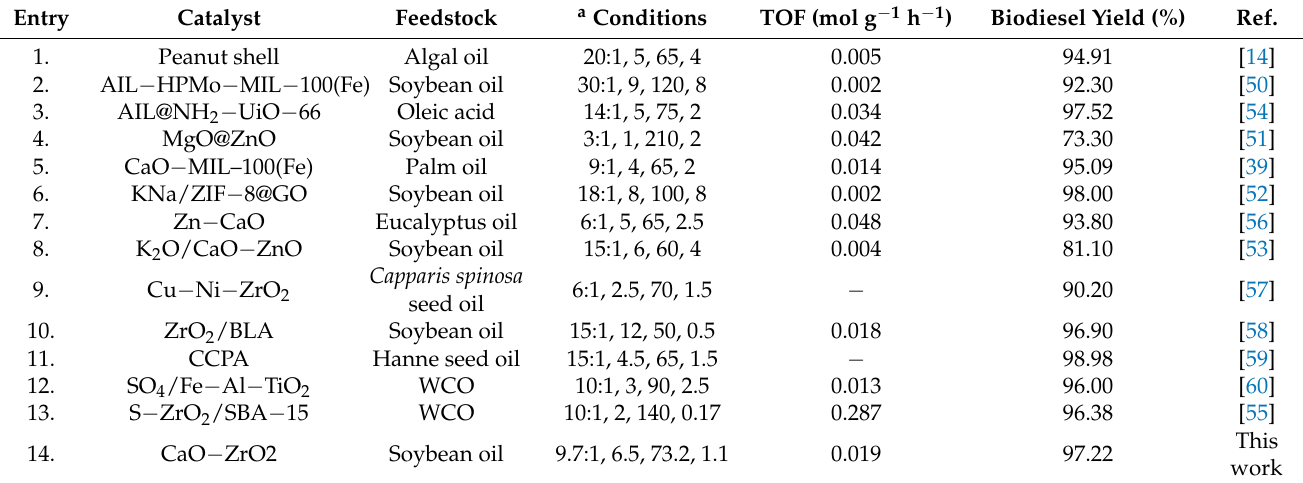
Table 5. Comparison of different heterogeneous catalysts for biodiesel production.